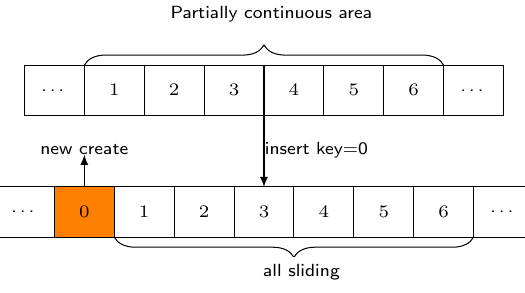
Figure 2. Partially continuous area.